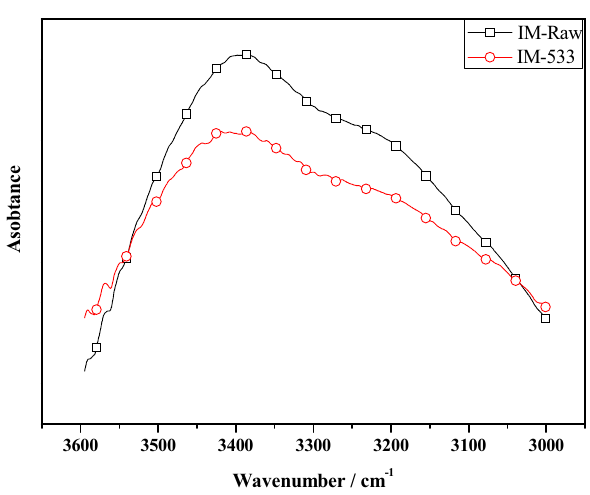
Fig. 7 Comparison of IM-Raw and IM-533 spectra in the region 3000–3500 cm -